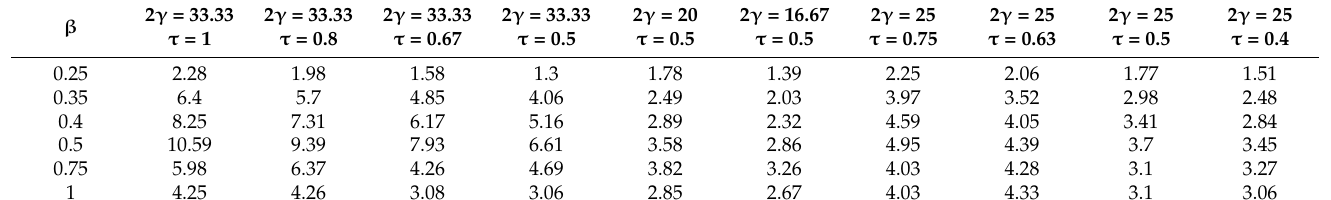
Table 11. Influence of β on peak SCFs.